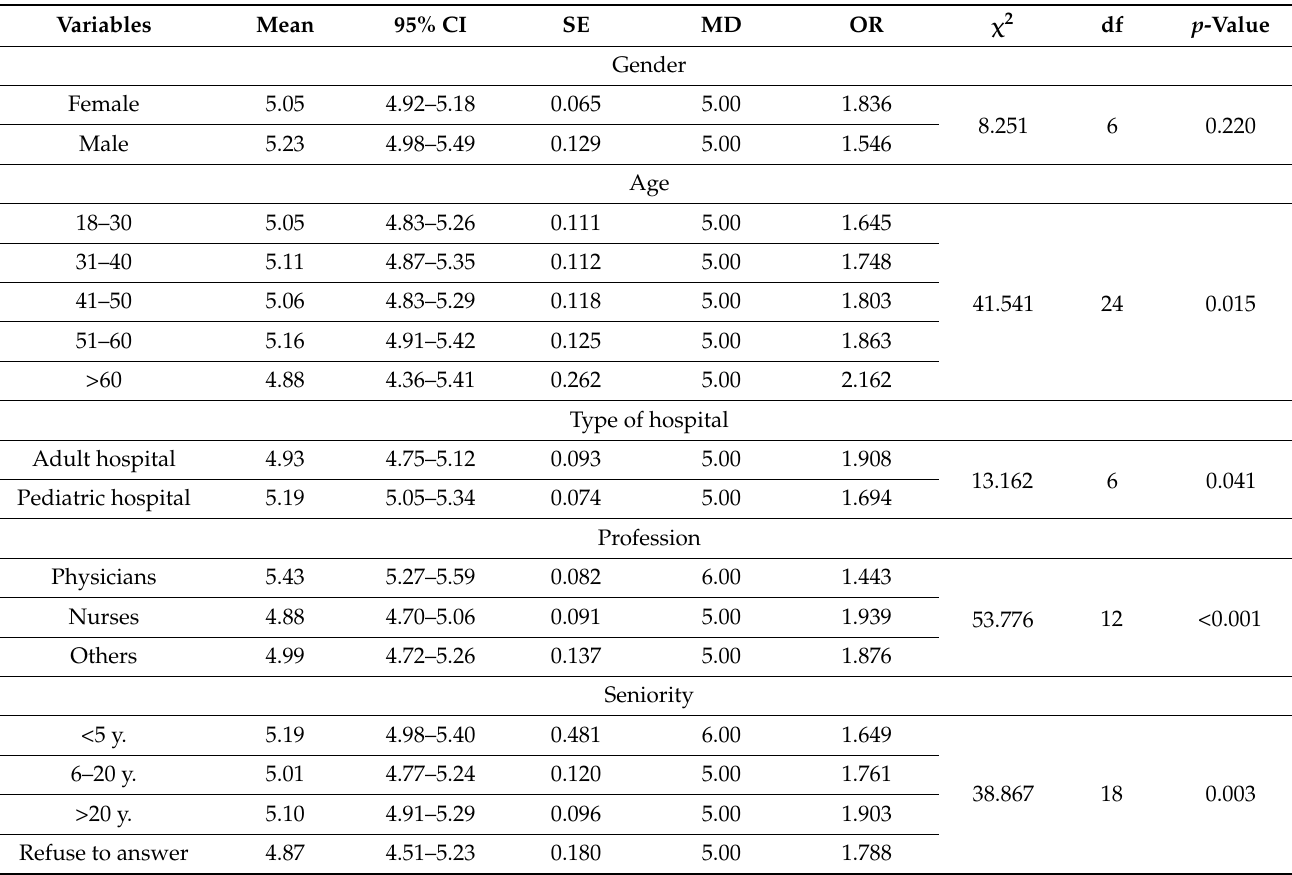
Table 3. Evaluation of mouth and nose covering mask to prevent influenza virus infection by sociodemographic category ( N =